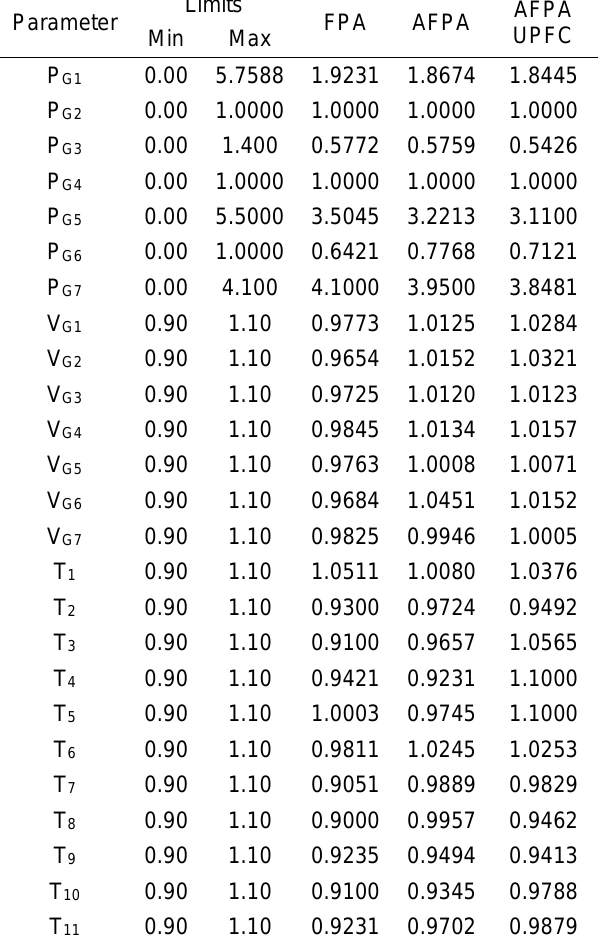
Table 8. Comparison of FPA, AFPA & AFPA-UPFC results